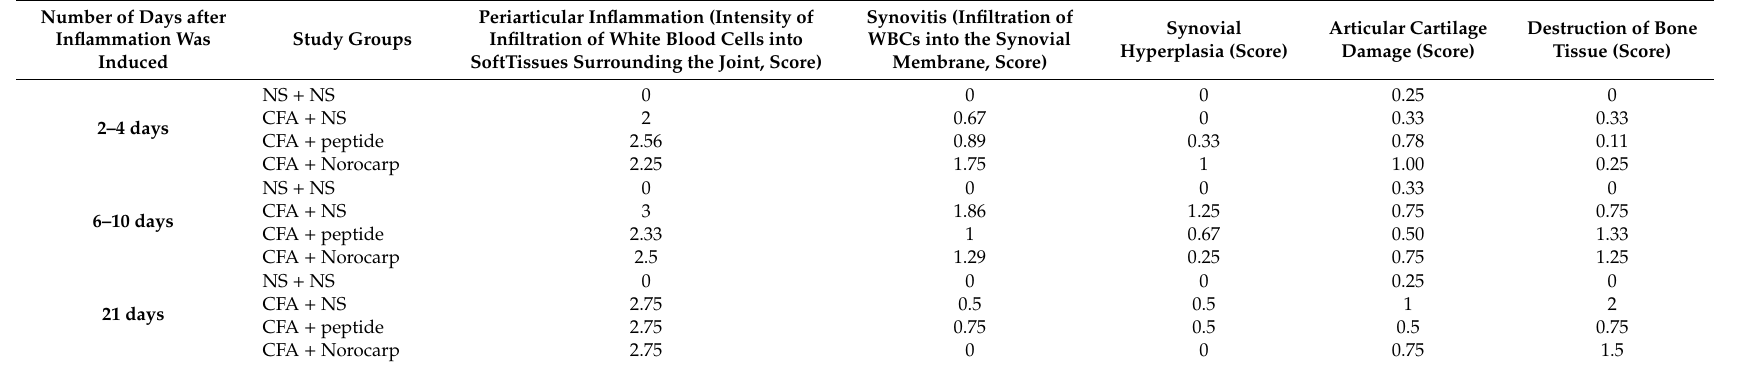
Table 1. Peptide 17.1 exhibits an anti-inflammatory protective e ff ect in mice with complete Freund’s adjuvant (CFA)-induced